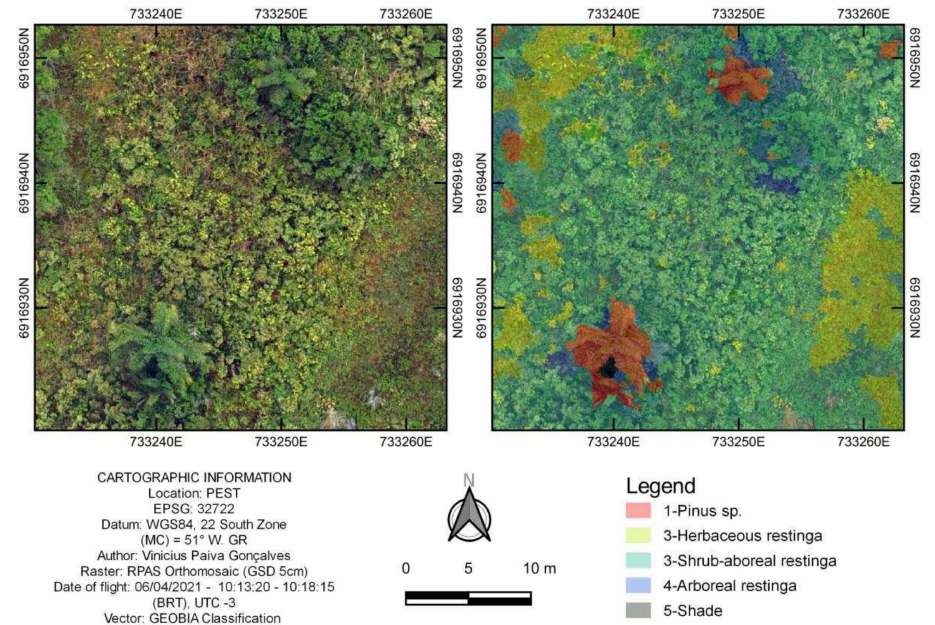
Figure 10. PEST classification detail showing the difference between a shrub and herbaceous species in a mosaic context and the jeriv á palm Syagrus romanzoffiana mistakenly classified as Pinus sp. CRS: EPSG 32722. Horizontal datum WGS84, UTM projection system, 22 South Zone. MC 51 ◦ W. GR. Raster: RPAS Orthomosaic (GSD 5 cm). Flight date: 06/04/2021, 10:13:20–10:18:15 Brasilia Time (BRT),